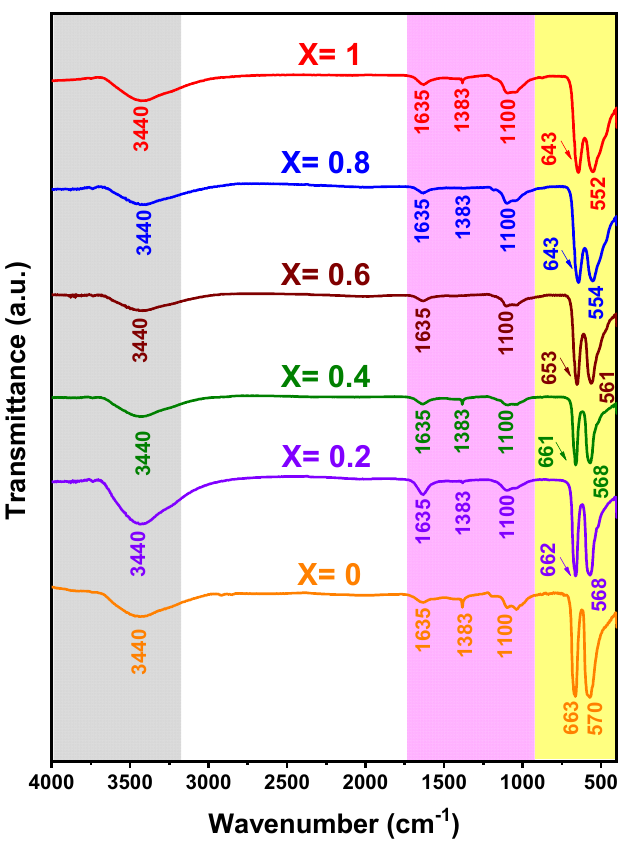
Figure 6. FT-IR spectra for all Mn X Co 3-X O 4 (0 ≤ X ≤ 1) samples. Table 2. Assignment of the FT-IR band frequencies observed for Mn X Co 3-X O 4 (0 ≤ X ≤ 1) samples and their comparison with the